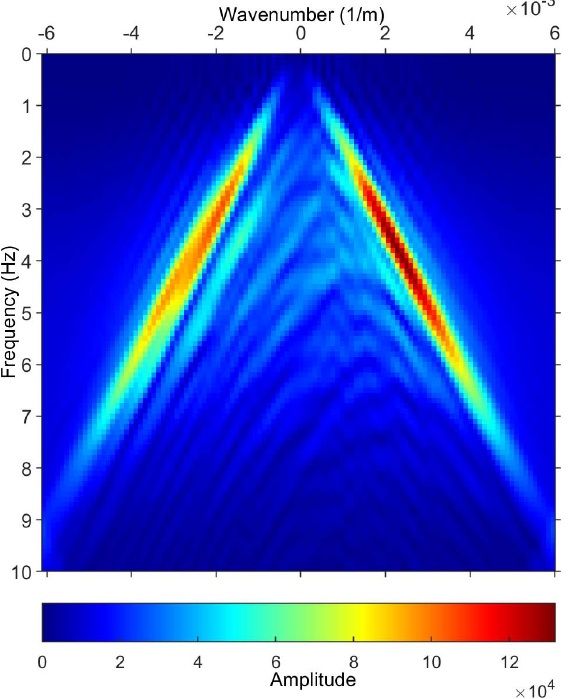
Figure 16. Frequency-wavenumber (F-K) amplitude spectra of the data shown in Figure